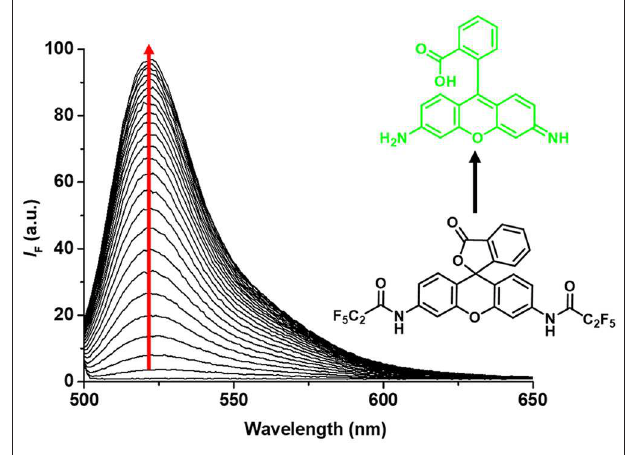
FIGURE 1 | Fluorescence emission spectra of ACS-HNE (5 µ M) over time (24h) in buffered elastase enzyme (2 µ M) solution (in PBS buffer, pH = 7.40); λ ex =